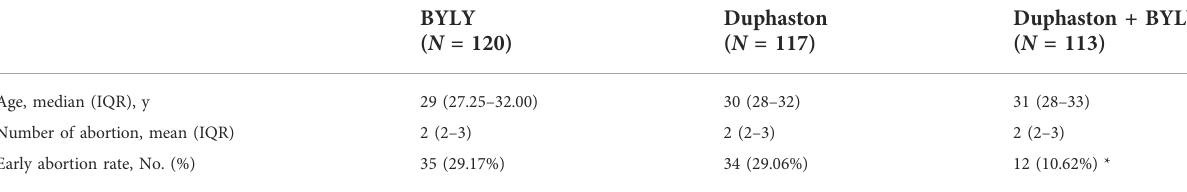
TABLE 2 Baseline characteristics and pregnancy outcomes in study